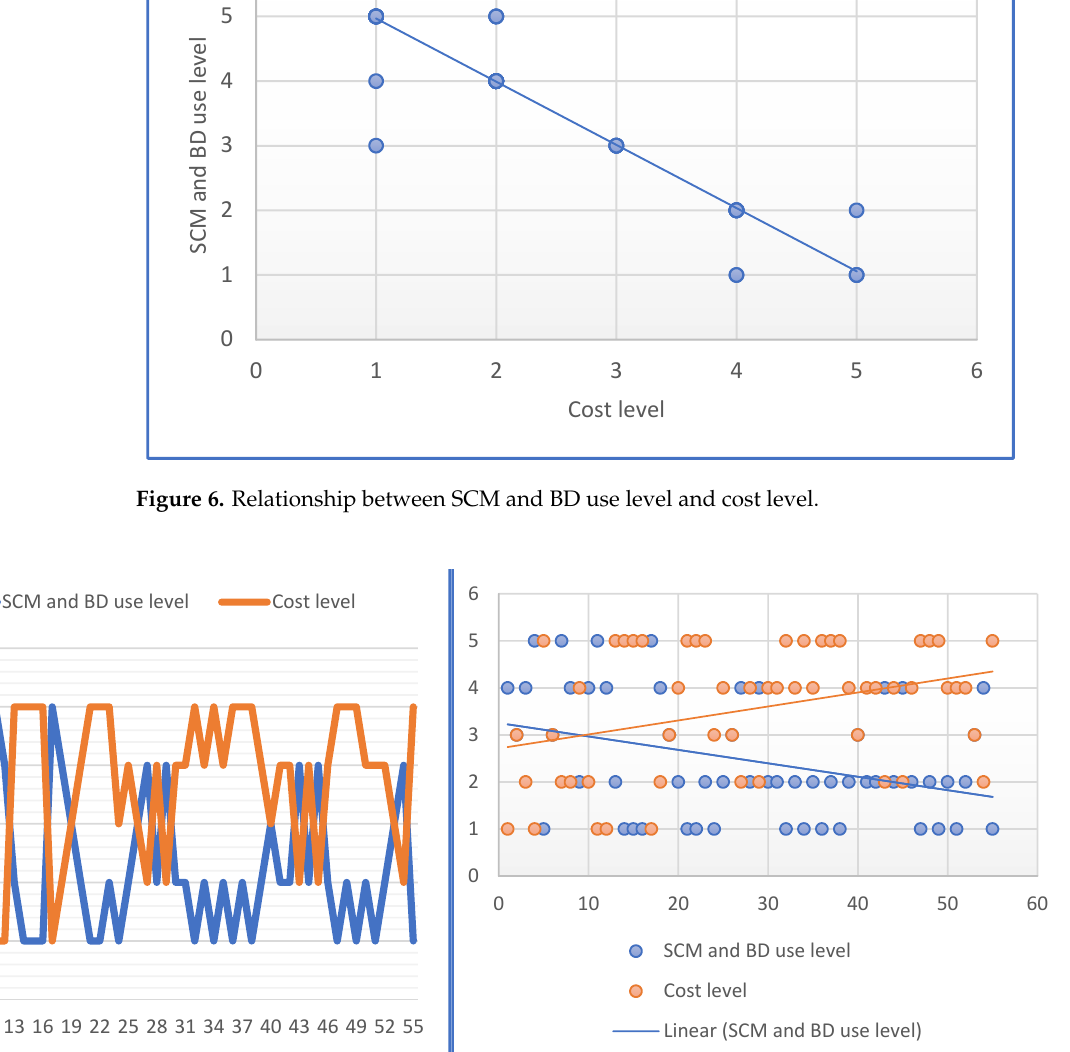
Table 6. Pearson correlation (SCM and BD use level and cost